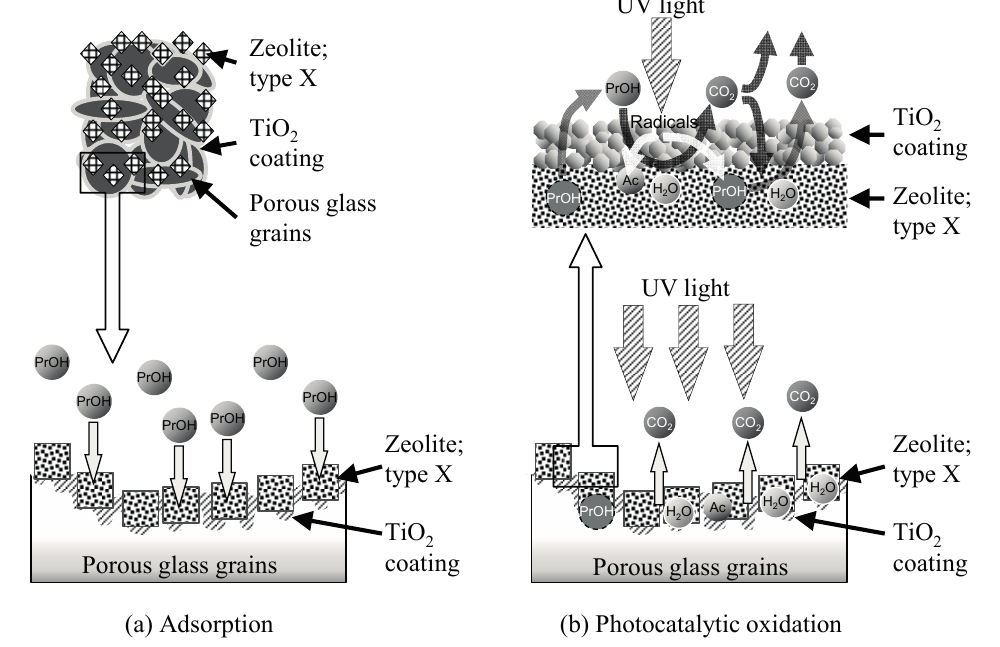
Figure 8. Schematic of ( a ) adsorption and ( b ) photocatalytic oxidation process by the TiO 2 -coated zeolite-porous glass